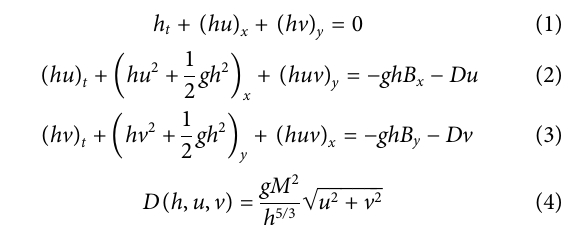
Frontiers in Earth Science |